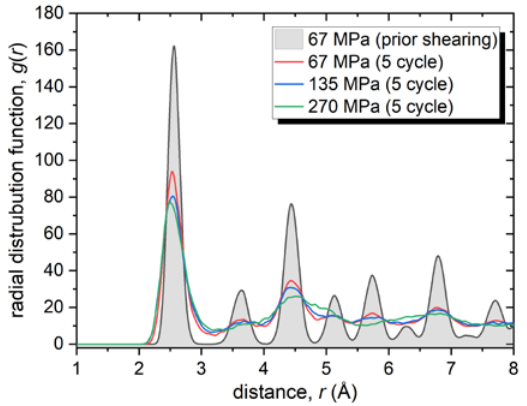
Figure 9. Radial distribution functions of the interface region in Model II during the fifth sliding cycle at different clamping pressures. For a comparison, the radial distribution function of a crystalline region in a system subjected to pressure of 67 MPa prior to sinusoidal shear displacements is presented (indicated as 67 MPa (prior shearing) in the legend).